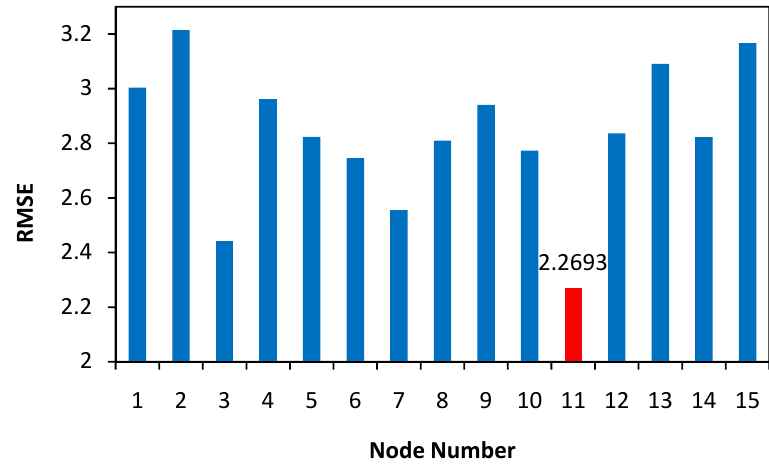
Figure 1. Performance of the network at different hidden nodes using QP